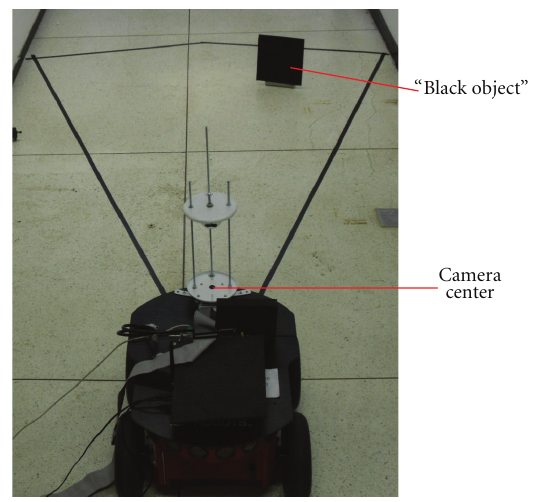
Figure 13: The overall system and the calibration environment.